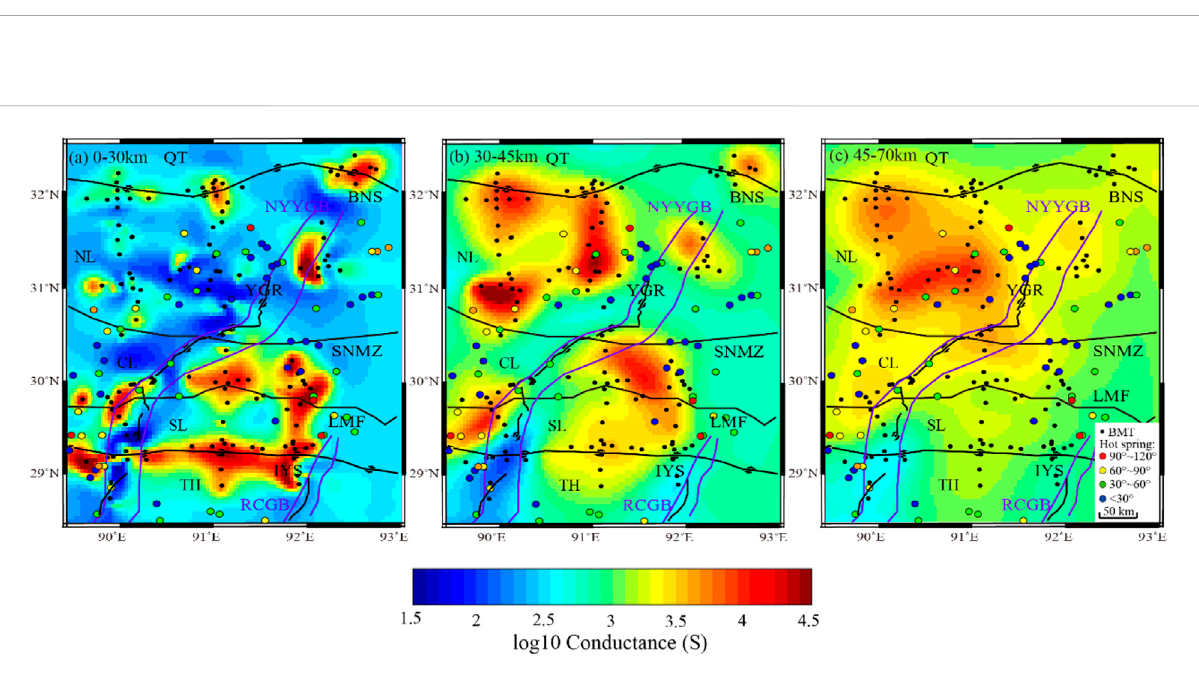
Frontiers in Earth